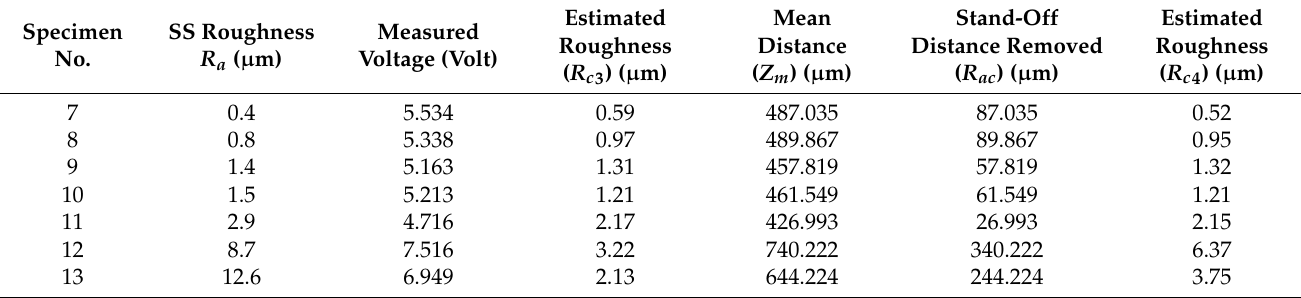
Table 4. Estimation of roughness for the remaining machined specimens using regression model.